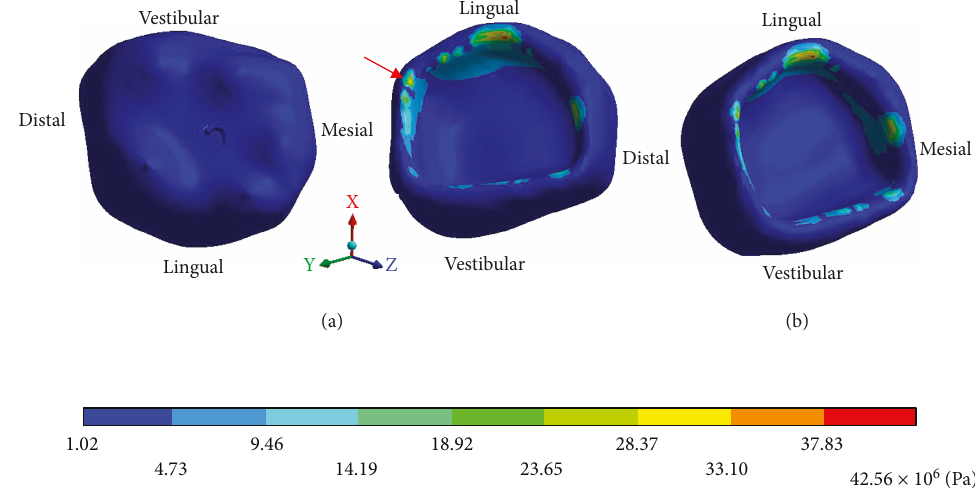
Figure 9: 1st degree caries : von Mises stresses in enamel: (a) occlusal view (b) cervical view.